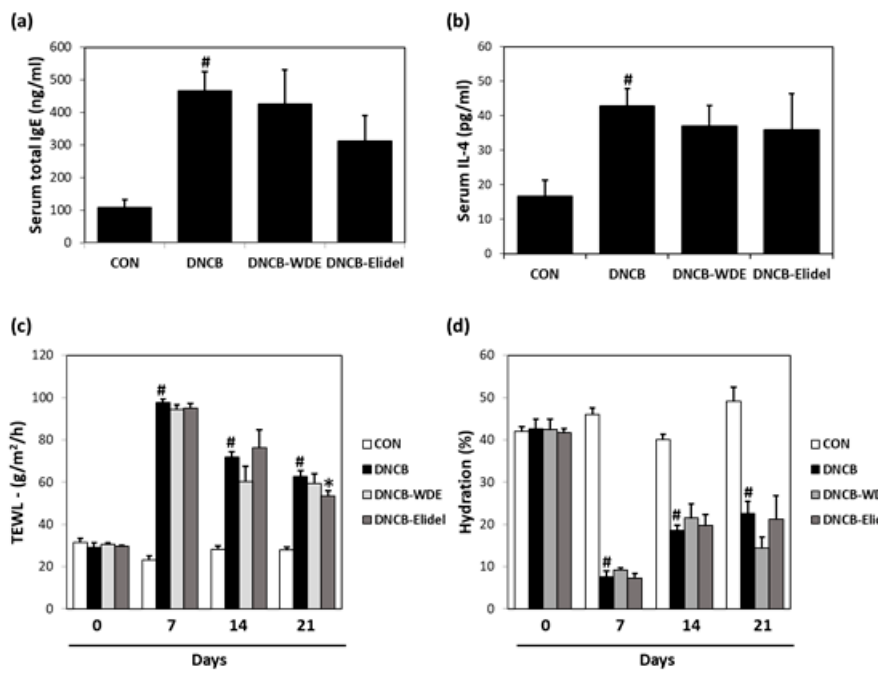
Figure 5. Effects of WDE on skin barrier function, serum IgE, and serum IL-4 on DNCB-induced AD-like symptoms in SKH-1 hairless mice. ( a ) Serum total IgE levels. ( b ) Serum total IL-4 levels. ( c ) Transepidermal water loss (TEWL). ( d ) Skin hydration values. Results are expressed as the means ± SEMs ( n = 7) of two independent experiments. # p < 0.05 vs. the CON group; * p < 0.05 vs. the DNCB group. EtOH extract of Wikstroemia dolichantha , CON: control group, DNCB: DNCB-treated group, DNCB-WDE: DNCB and 1% WDE-treated group, DNCB-Elidel: DNCB and 1% Elidel-treated group.